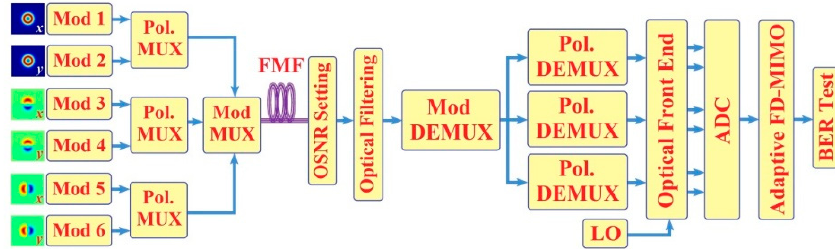
Figure 12. Configuration of a six-mode coherent transmission system [29].